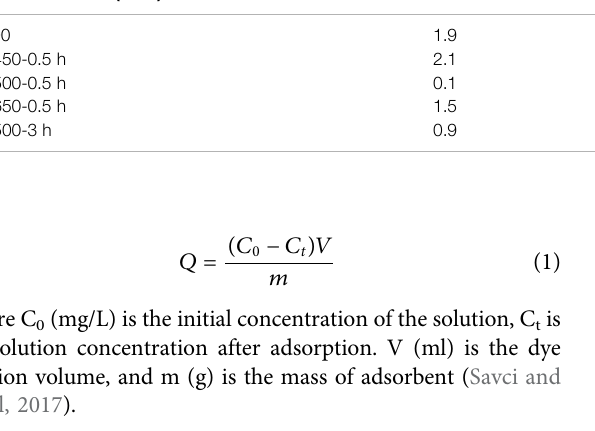
TABLE 3 | The effect of pyrolysis temperature and activation time on the characteristics of activated bio-char (proximate analysis). Sample name-pyrolysis temperature ( ° C)-activation time (hour)